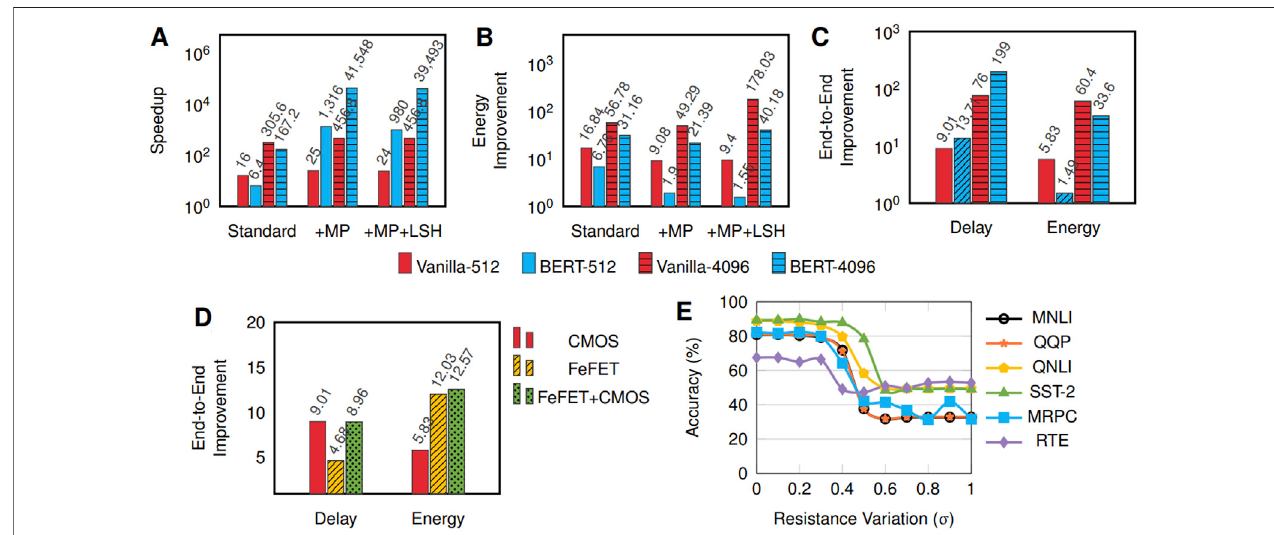
FIGURE7| Latency (A) andenergy (B) improvementsofevaluatingtheMHAwithandwithoutmodelparallelism (MP)andsparsity andFeedforwardunitsofVanilla transformersandBERTwithsequencelengthof512and4096usingCMOS-basediMTransformercomparedtoGPUBaseline.End-to-endimprovement (C) ofCMOS- based iMTransformer for Vanilla transformers and BERT with sequence length of 512 and 4096 compared to GPU baseline (D) End-to-end improvement of iMTransformerforVanillatransformerswithsequencelengthof512usingCMOS,FeFETandCMOS+FeFETiMTransformerimplementationcomparedtotheGPU baseline. (E) Effects of crossbar resistance variation on the accuracy the GLUE